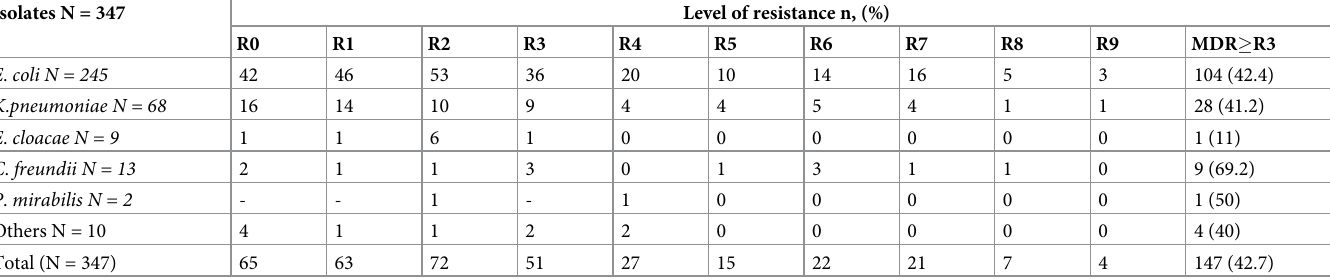
Table 3. Multidrug resistance profiles of Enterobacteriaceae isolates among food handlers at the University of Gondar Comprehensive Specialized Hospital and Students ‘Cafeterias, Northwest Ethiopia, February to June 2021. Isolates N = 347